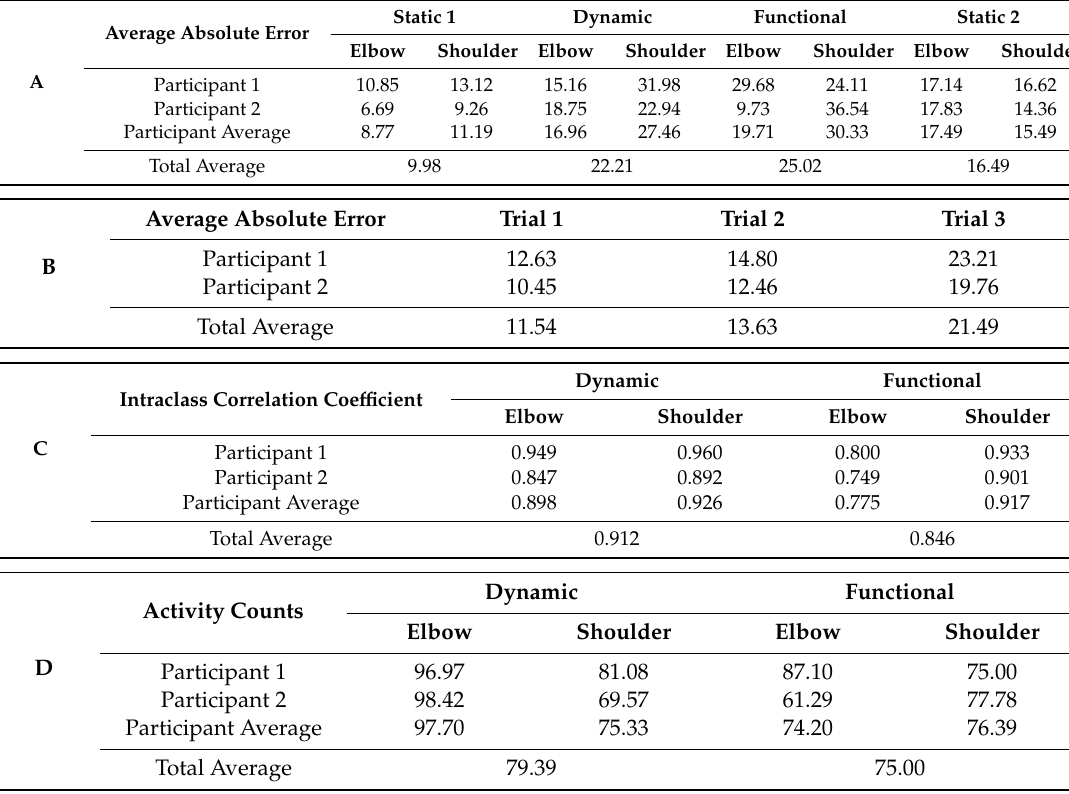
Table 1. Results across all